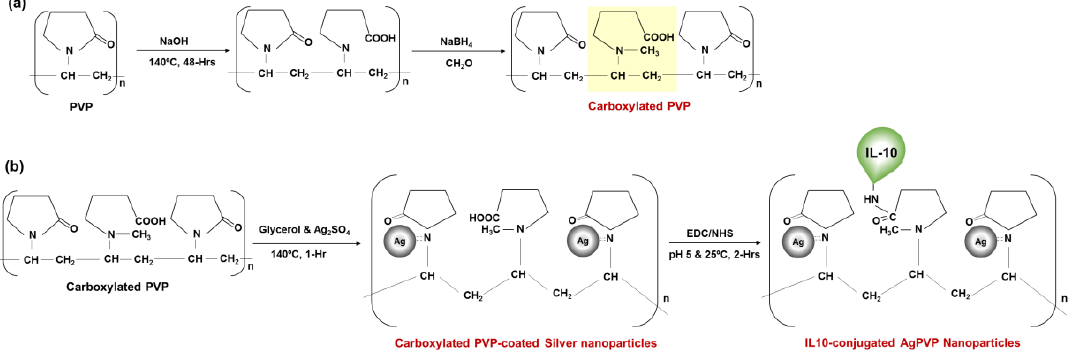
Figure 1. Representation of the production of Interleukin-10(IL-10) conjugated to carboxylated poly (vinylpyrolidone) (PVP)-coated silver nanoparticles. ( a ) Ring-opening and carboxylation of PVP by basic hydrolysis at high temperature and protection of the pyrrolidone nitrogen from ring closure; ( b ) Synthesis of Ag-PVP-COOH by the polyol method using silver sulfate as the precursor and glycerol as the reducing agent and solvent; and covalent conjugation of Ag-PVP-COOH with recombinant mouse IL-10 using EDC/NHS (1-ethyl-3-(3-dimethylaminopropyl) carbodiimide and N-Hydroxysuccinimide) chemistry.